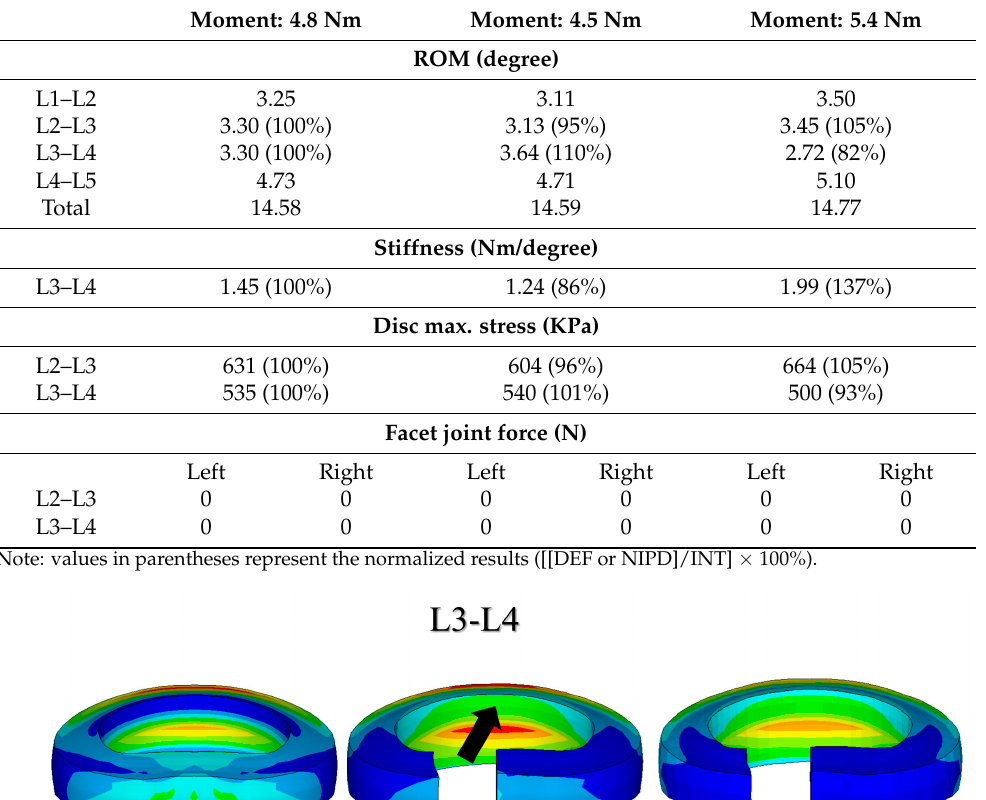
Table 2. Comparison of the biomechanical characteristics among the three FE models in flexion. INT Moment: 4.8 Nm